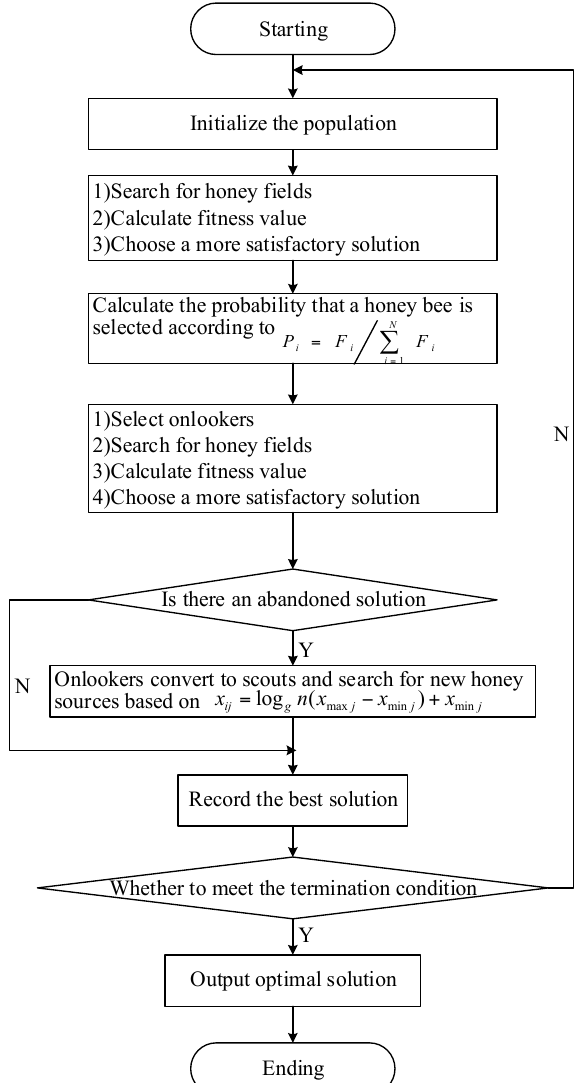
Figure 6. Schematic of the artificial bee colony algorithm.